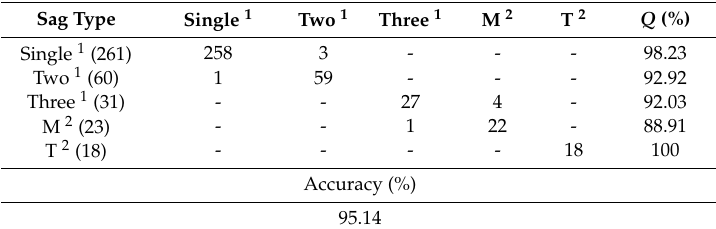
Table 3. Experiment 2